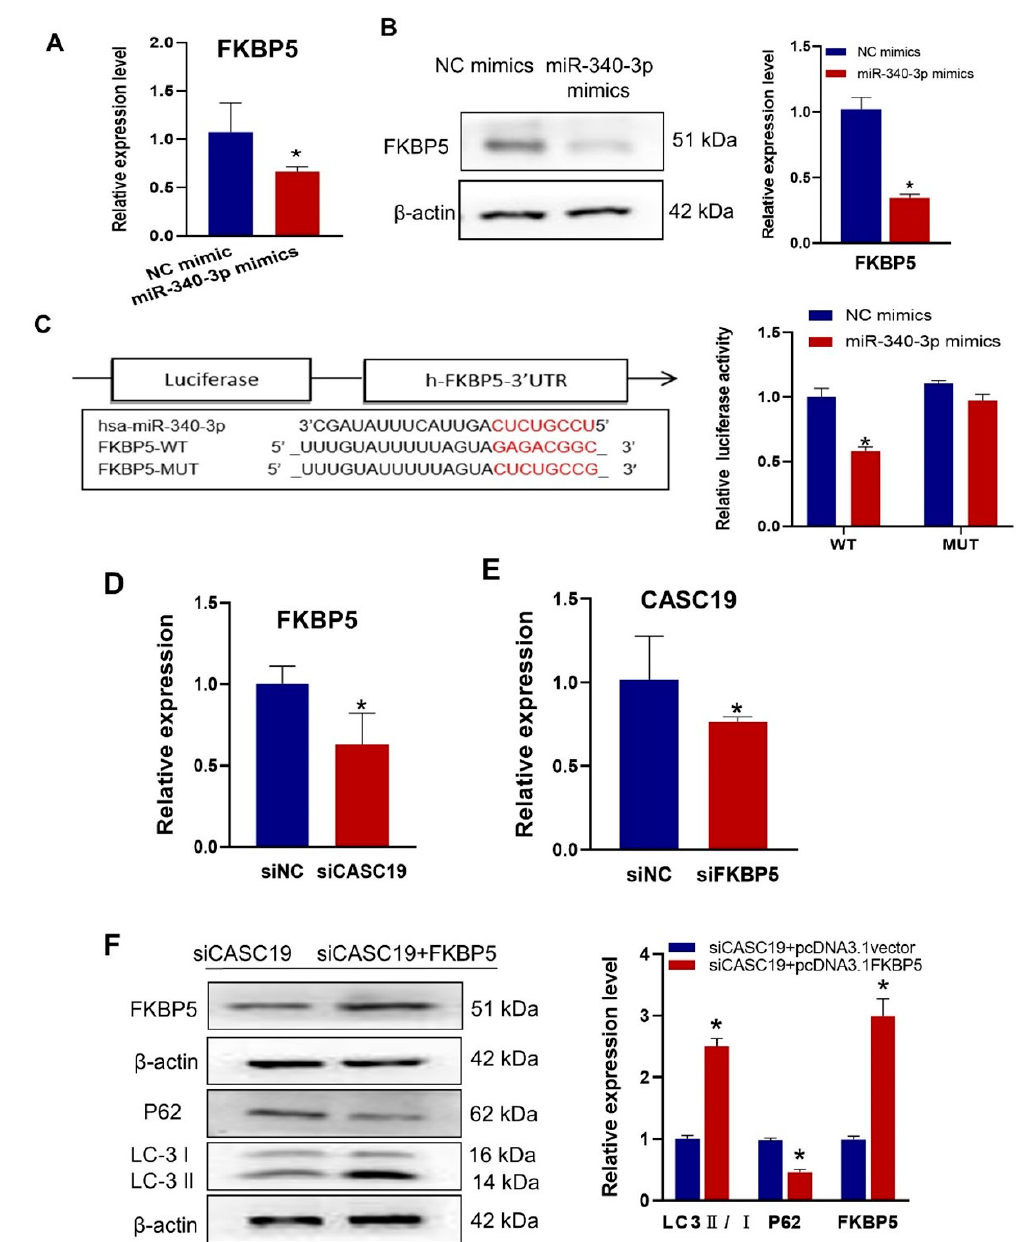
Figure 5. CASC19 positively regulated the expression of FKBP5 through miR-340-3p: ( A , B ) RT- qPCR ( A ) and Western blot ( B ) assay of the expression of FKBP5 in CNE2R cells transfected with miR-340-3p mimics or its control; ( C ) prediction of the target binding sites of FKBP5 and miR-340-3p was verified with the dual-luciferase reporter assay; ( D ) the expression of FKBP5 in CNE2R cells with or without transfection of siCASC19; ( E ) the expression of CACS19 in CNE2R cells with or without transfection of siFKBP5; ( F ) Western blot assay of FKBP5, P62, and LC3 protein in CNE2R cells co-transfected with siCASC19 and FKBP5 overexpression plasmid. * p < 0.05 compared with the corresponding control.